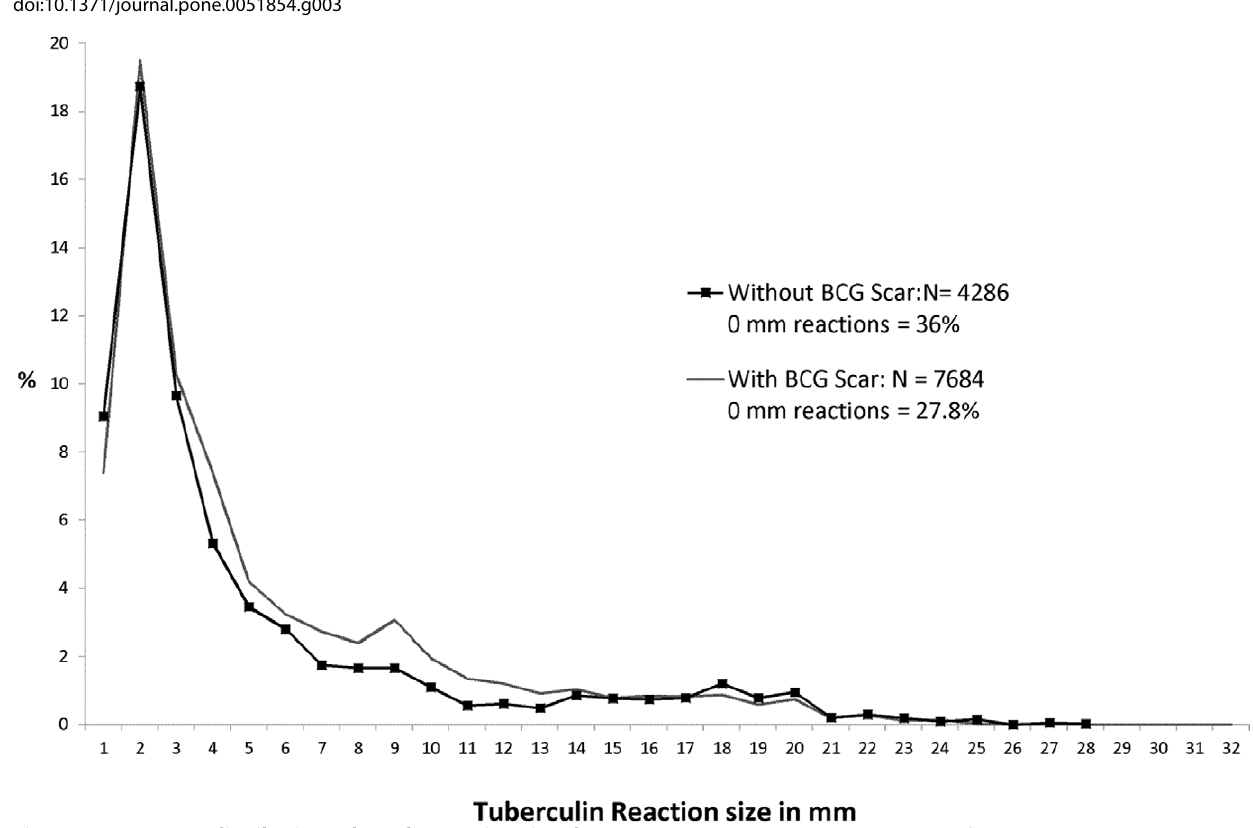
Figure 4. Frequency distribution tuberculin reaction sizes by BCG scar status. Survey II ; Stratum : Both ; Age : 1–9 years. doi:10.1371/journal.pone.0051854.g004 PLOS ONE | www.plosone.org